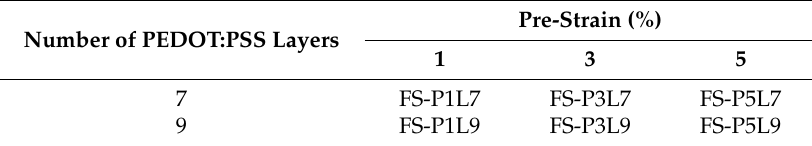
Pre-Strain (%) Pre-Strain (%) 1